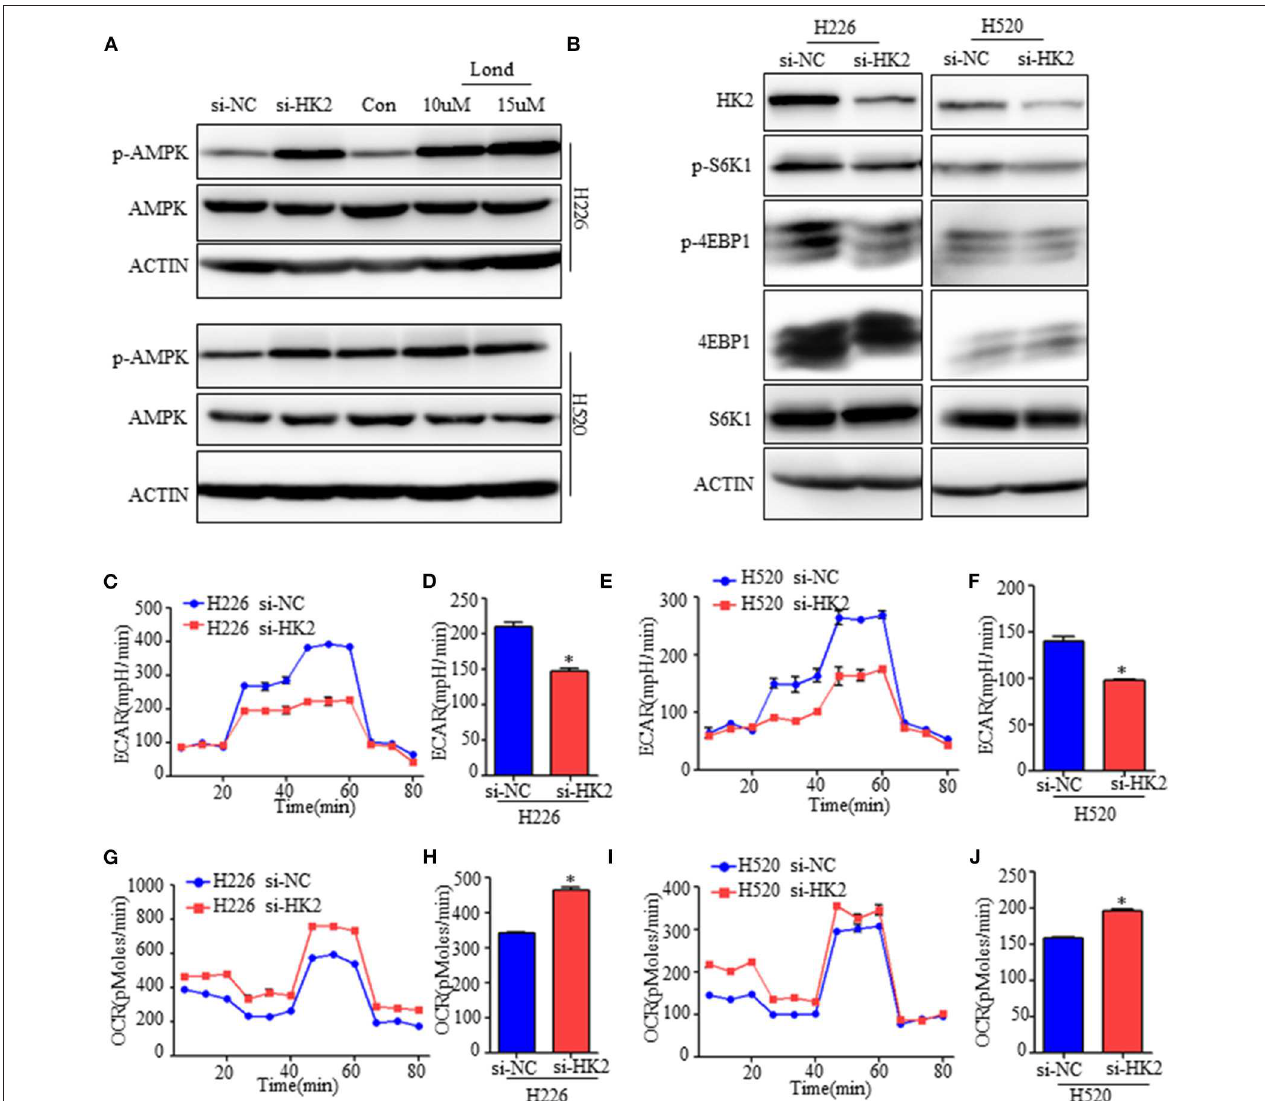
FIGURE 4 | Inhibiting HK2 activates AMPK and subsequently inhibits mTORC1 activity. (A) Western blot showing the expression of phospho-AMPK in H226 si-HK2- and H520 si-HK2-transfected cells compared with that in siNC-transfected cells or cells treated with different doses of lonidamine. (B) Immunoblot showing the expression of phosphor-S6K1 and phosphor-4EBP1 in H226 siHK2- and H520 si-HK2-transfected cells compared with that in H226 siNC- and H520 siNC-transfected cells, respectively. (C,D) Seahorse metabolic analysis of the extracellular acidification rate (ECAR) in H226 si-NC- and siHK226-transfected cells. (E,F) Seahorse metabolic analysis of ECAR in H520 si-NC- and siHK520-transfected cells. (G,H) Seahorse metabolic analysis of oxygen consumption rates (OCRs) in H226 si-NC- and siHK226-transfected cells. (I,J) Seahorse metabolic analysis of OCRsin H520 si-NC- and siHK520-transfected cells. * p <